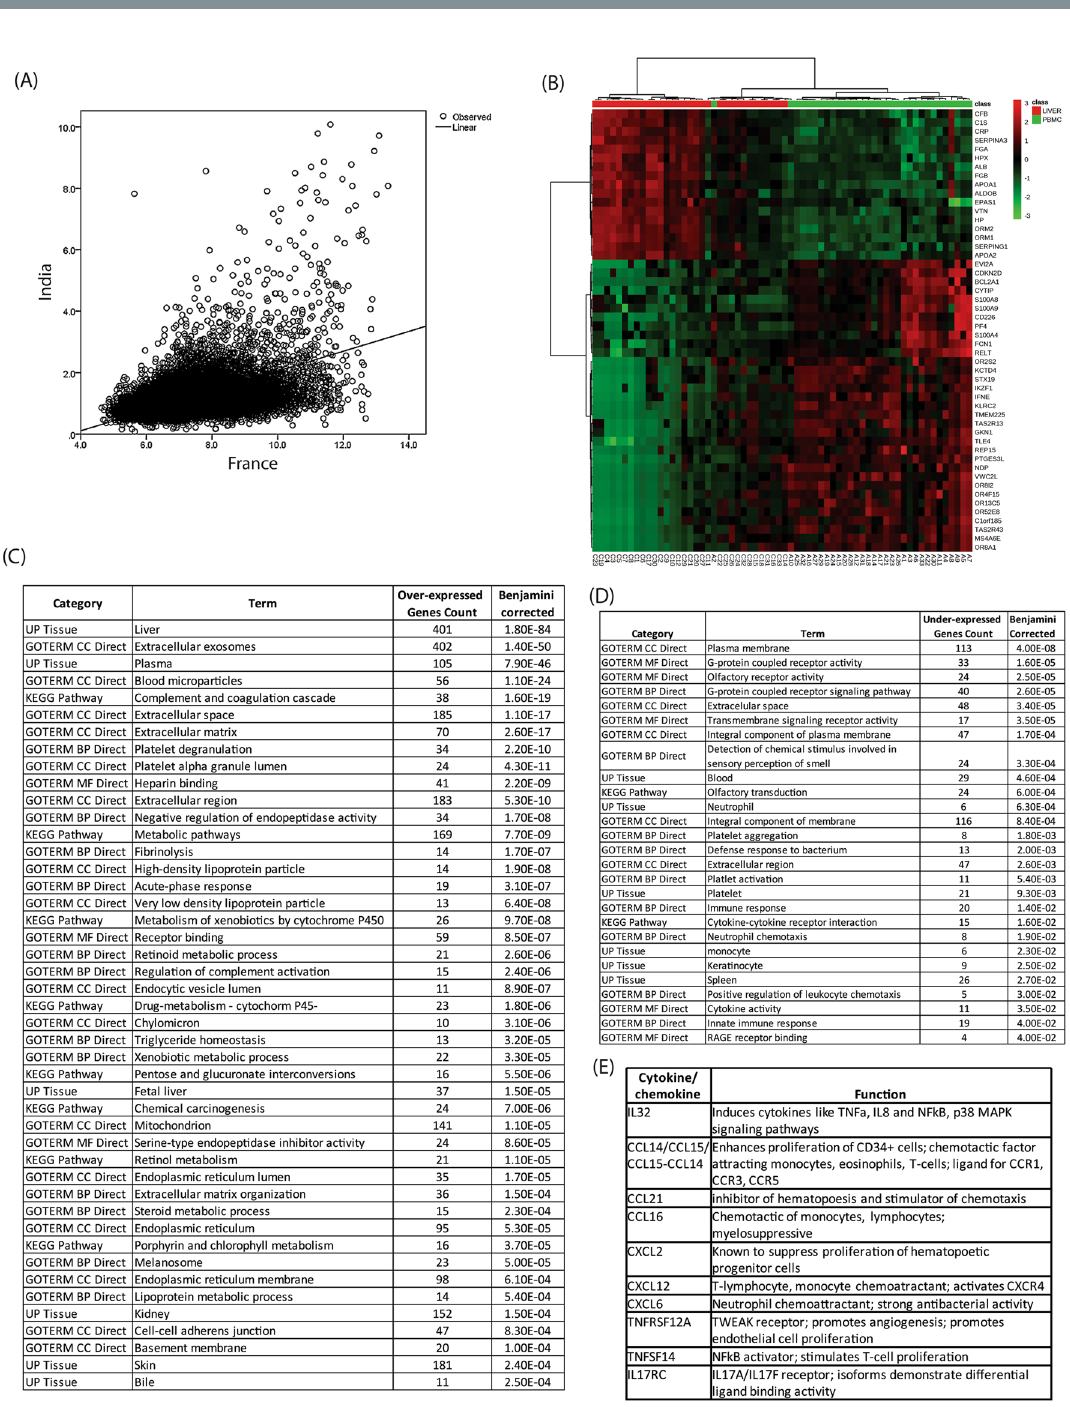
Comparative anlysis. Livers of French non-responders exhibited enrichment in hemoglobin-related genes, in particular, hemoglobin-coding genes such as HBB , HBA1 , HBD , HBG2 , and HBE1 . Examination of hemoglobin-erlated genes in the Indian non-responder’s livers also identified an over-expression of HBM and HBQ1 . It is interesting to note that HBM , HBQ1 , HBD , HBE1 and HBG2 are produced in fetal livers.